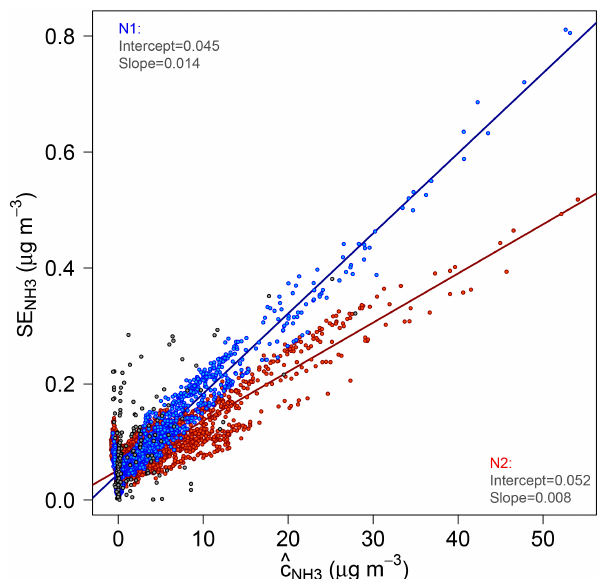
Figure 6. SE NH vs. ˆ c NH (instruments N1 and N2); coloured cir- 3 3 cles represent 1 min averages, and grey circles display the differ- ence in concentration determined by instrument N1 and N2 for half- hourly means ( (cid:49) 30 = | N1 − N2 | ) of the individual 1min values; re- gression was carried out with the Deming method (Linnet,